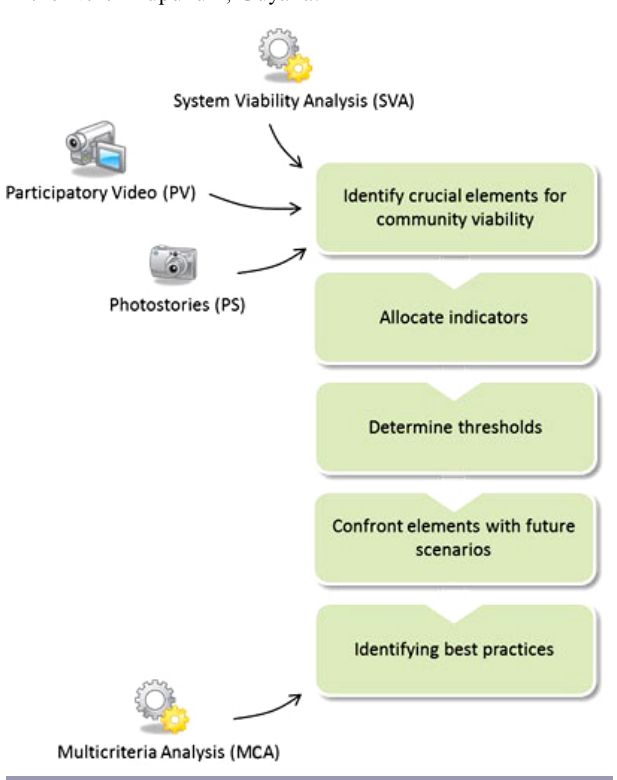
Fig. 2 . Main steps leading to the selection of six best practices in the North Rupununi,